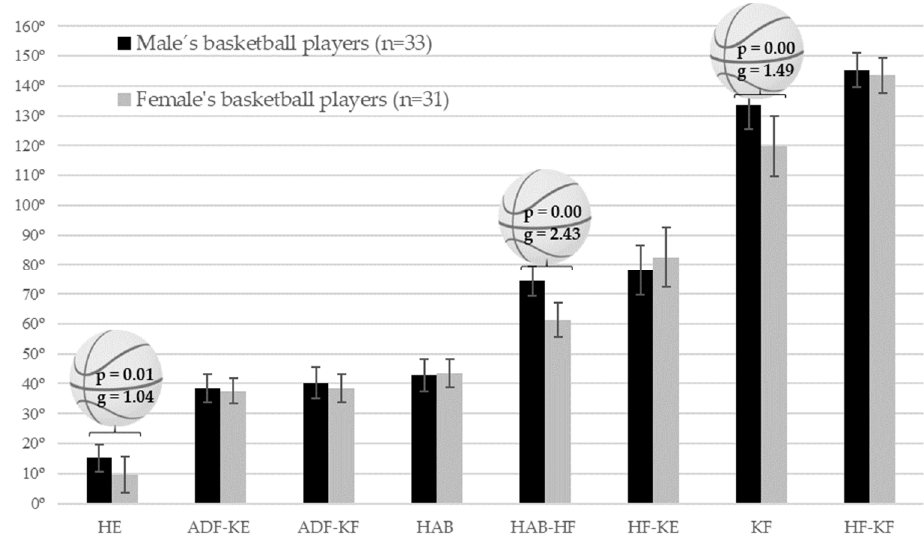
Figure 2. Gender differences in range of motion (mean values of each range of motion test) of the basketball players ( p = significant differences by gender; g = effect size of the difference).